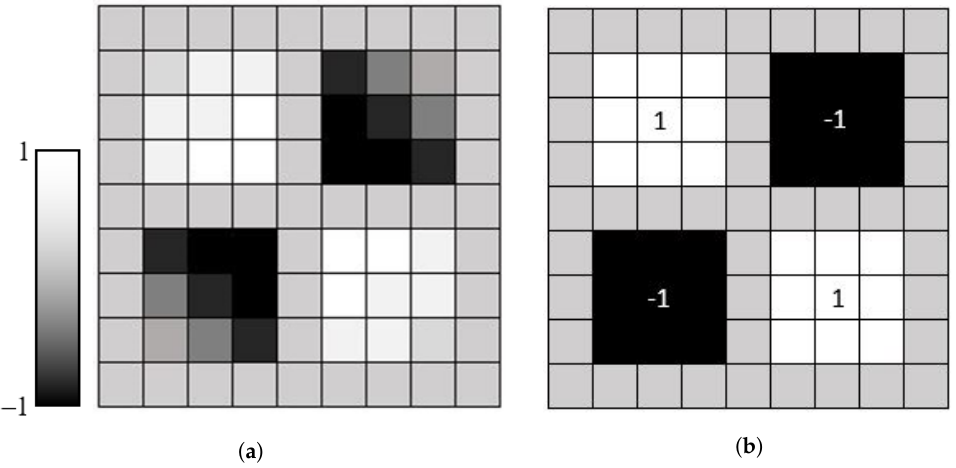
Figure 5. Illustration of box filter approximation. ( a ) Gaussian second order partial derivatives in the xy -direction and ( b ) approximation using box filters.